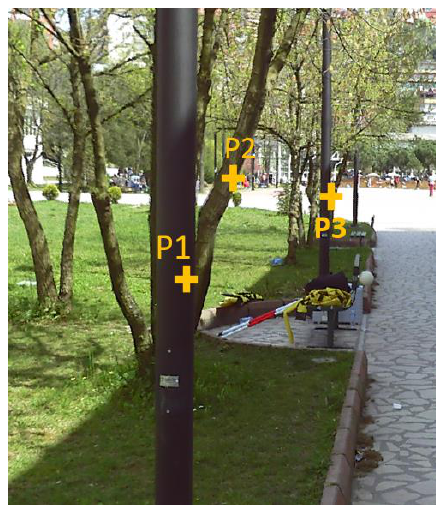
Figure 11. Test objects and selected points P1-P3 for error ellipsoid plotting. P1 and P3 selected from lamp poles, and P2 from branch of tree